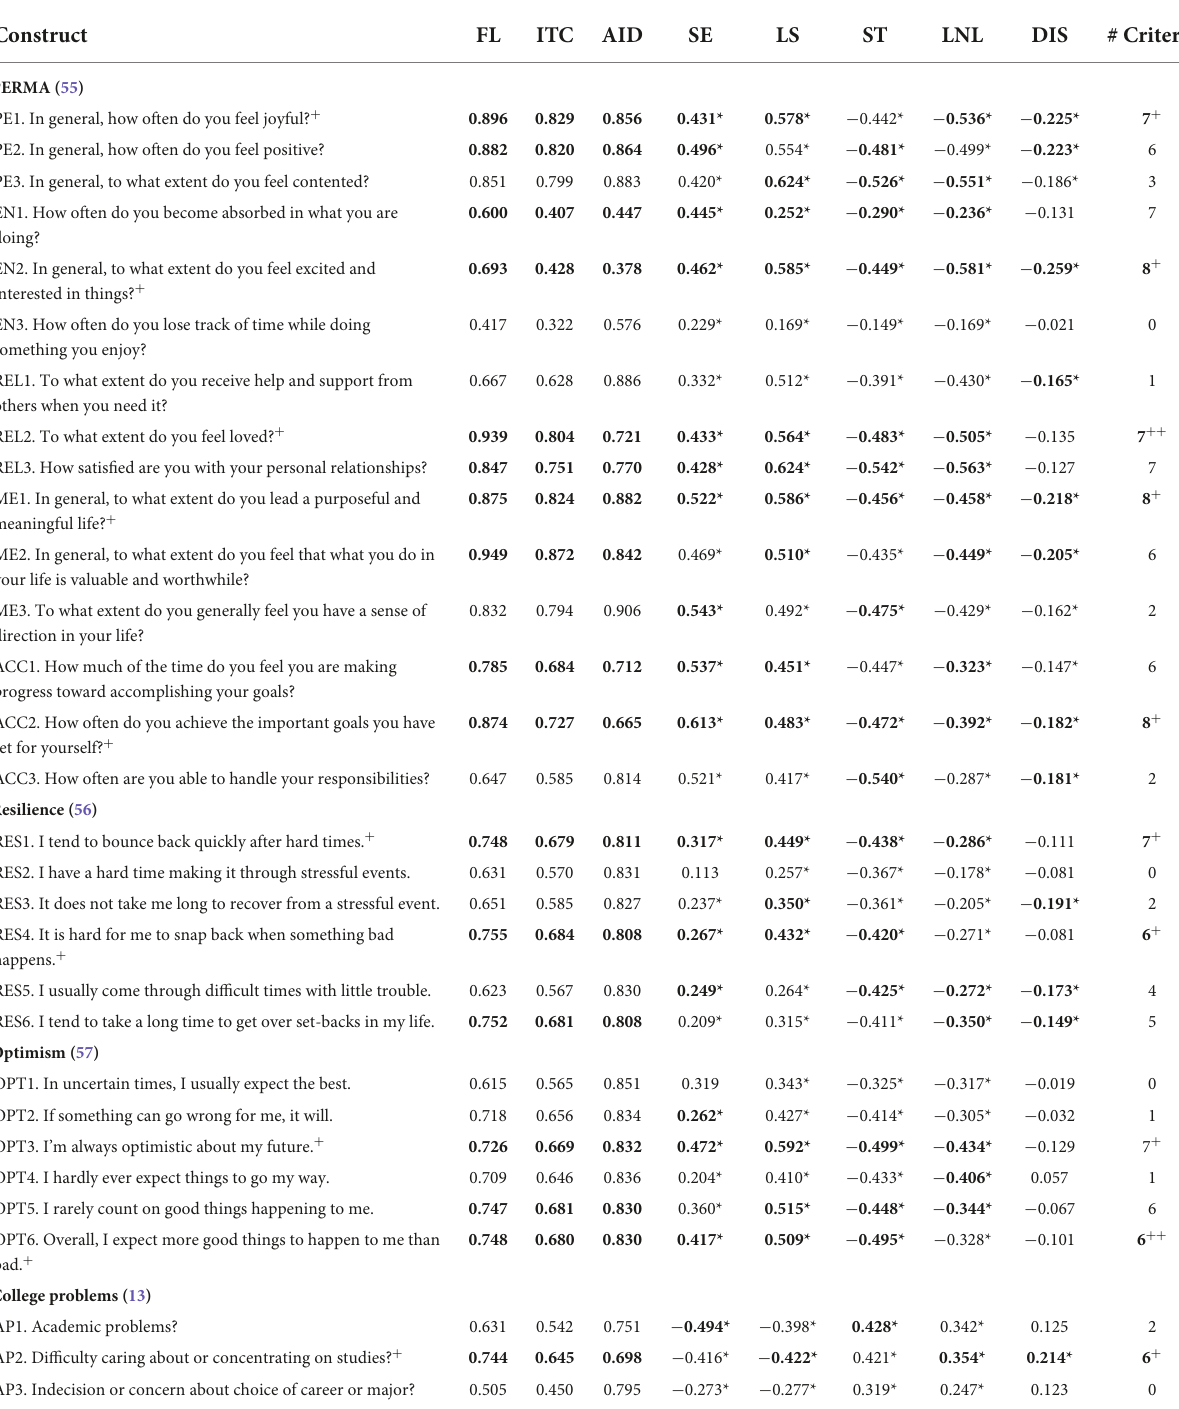
TABLE 1 Item pool and initial item